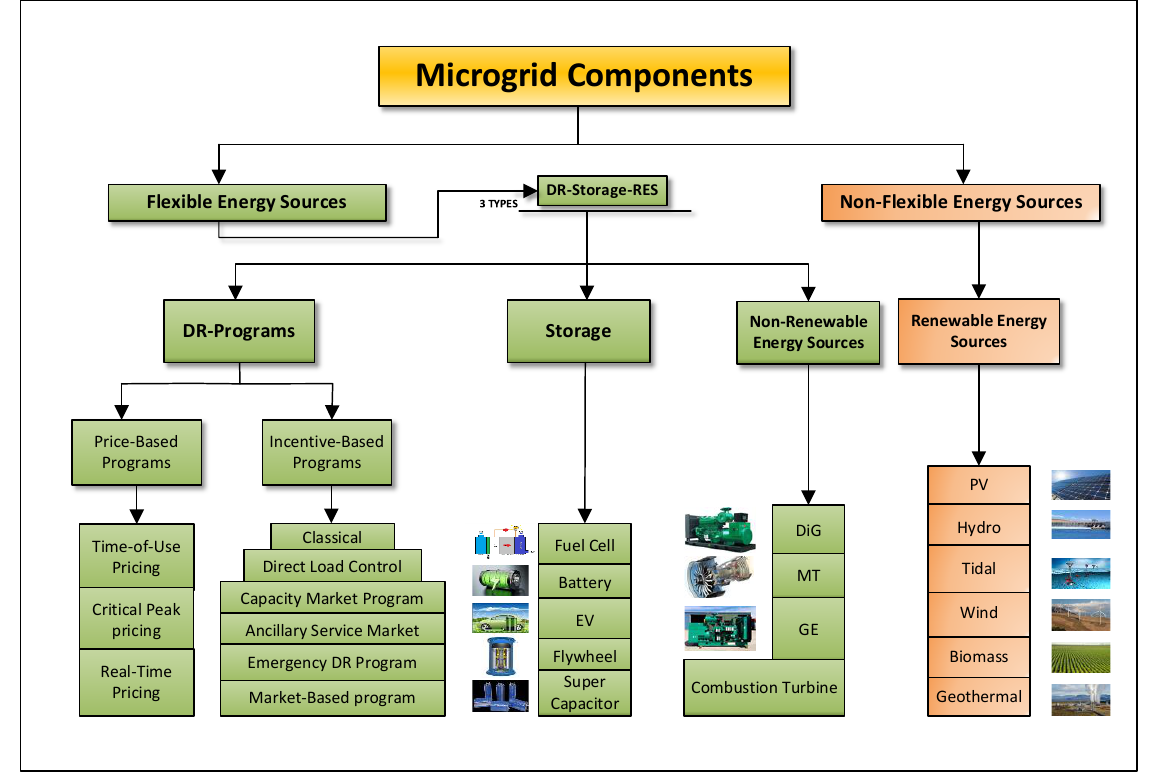
Figure 3. Microgrid components.